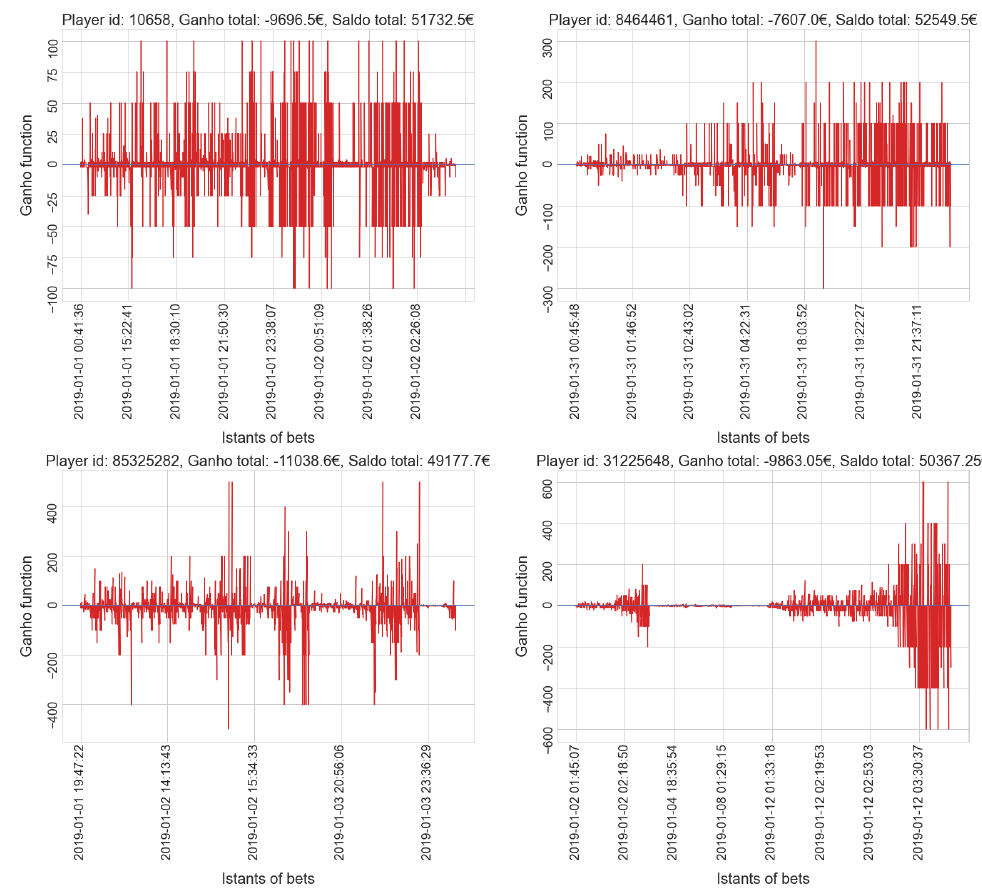
Figure 23. Time series plot of four potential high-risk pathological